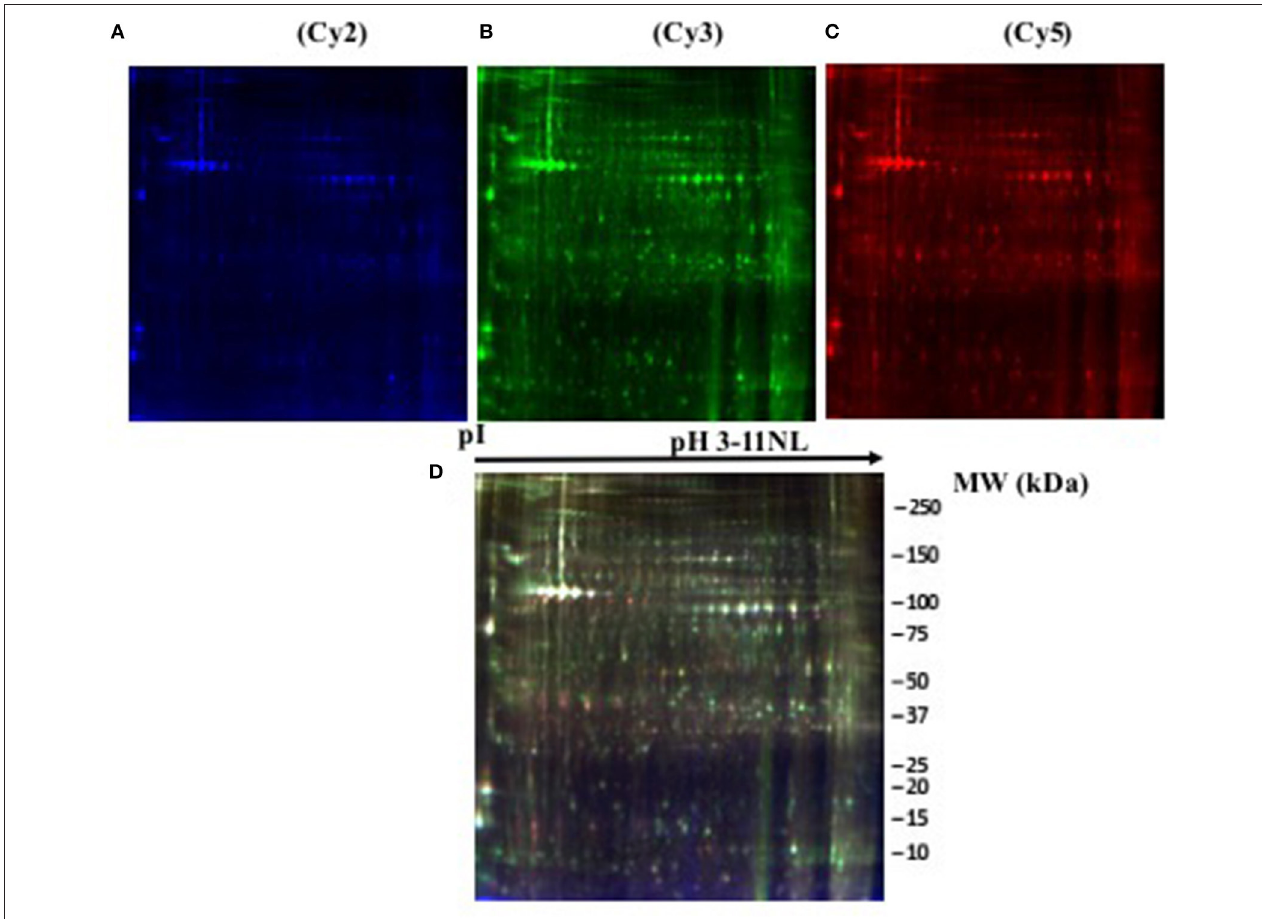
FIGURE 1 | Representative two-dimensional differential in gel electrophoresis (2D-DIGE) of Octopus vulgaris paralarvae proteins corresponding to condition 1. Gel was scanned to obtain single images corresponding to: (A) (Cy2, blue), (B) (Cy3, green), (C) (Cy5, red) labelled samples, and (D) (overlay gel image of the three dyes). Details in section 2D Differential in Gel Electrophoresis (2D-DIGE): Sample Preparation and Protein